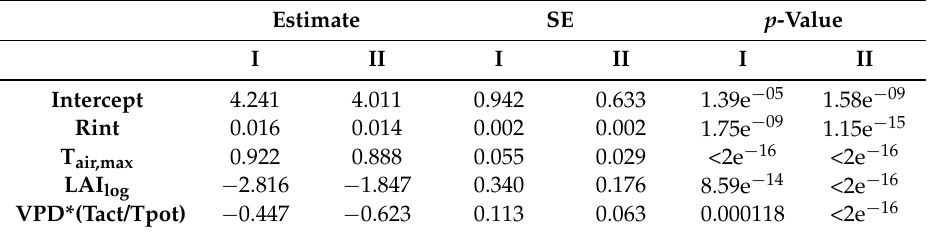
Table 3. Statistics of the multiple linear regression model developed using a forward stepwise-based selection procedure and quantile regression analyses for predicting T c,max (= maximum daily canopy